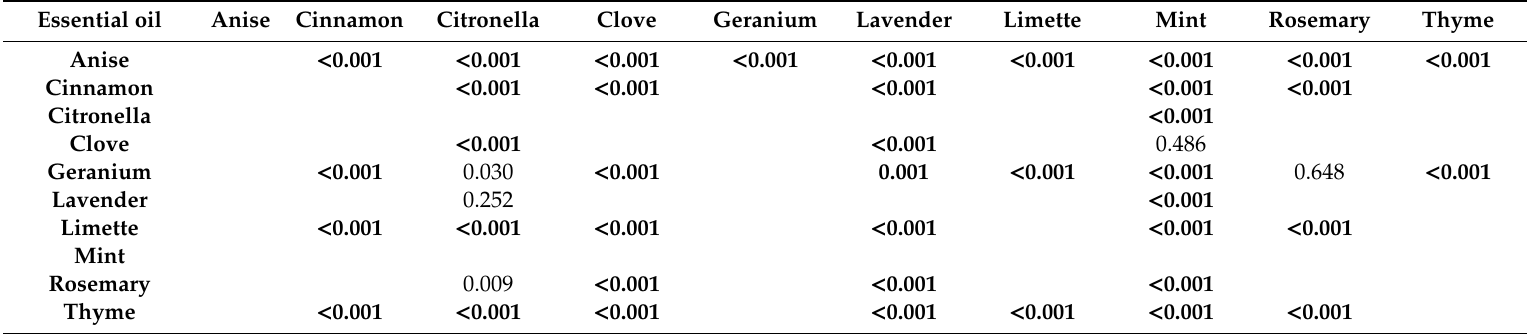
Table A3. Levels of statistical significance ( p ) in Fisher’s post post-hoc test of EOs activity against C.